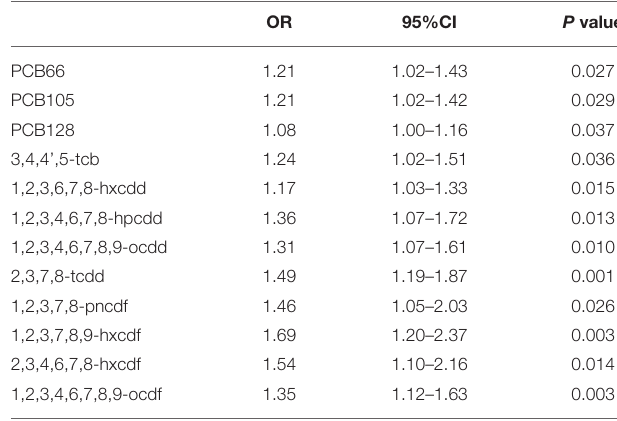
TABLE 4 | The associations of dioxins, furans, and coplanar PCBs metabolites with hypertension ( n = 2,131).